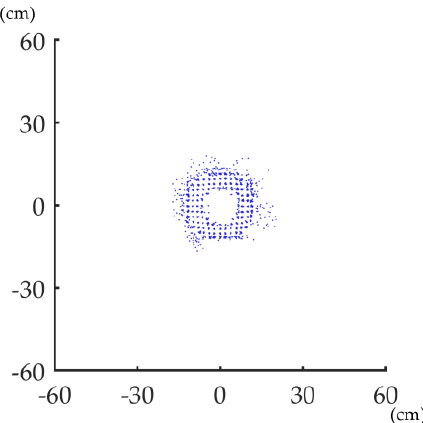
Figure 4. A PLS-based horizontal projected stem point cloud with good co-registration.